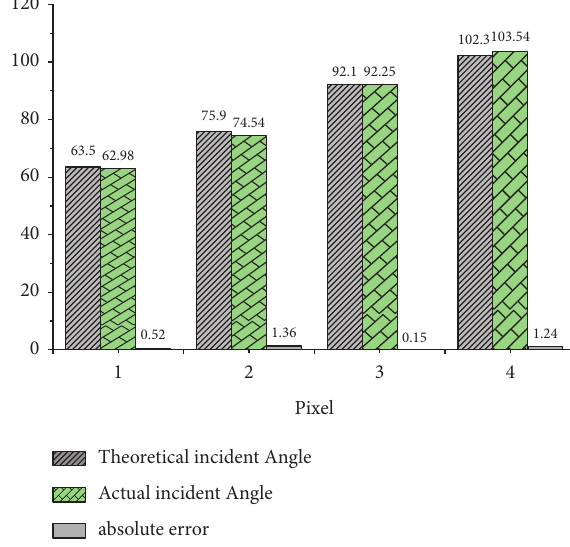
Figure 8: Calculation error of incident